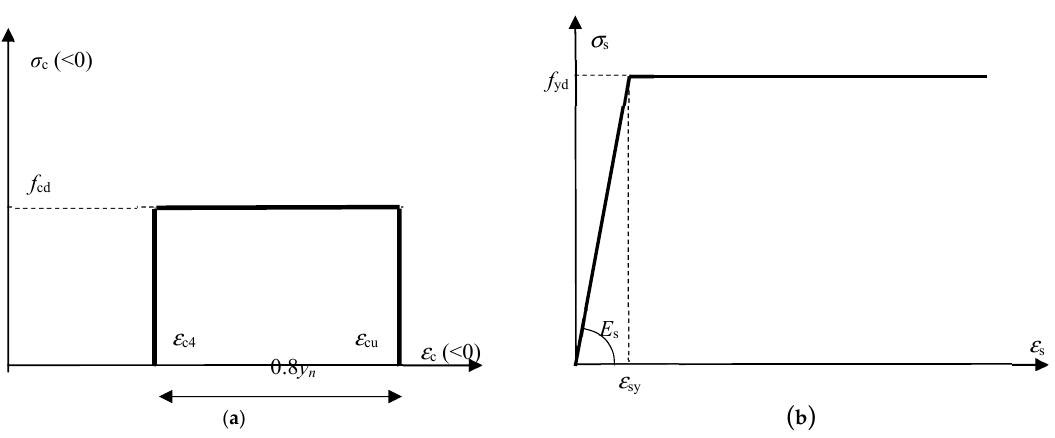
Figure 2. Material constitutive laws: ( a ) concrete, ( b ) steel.